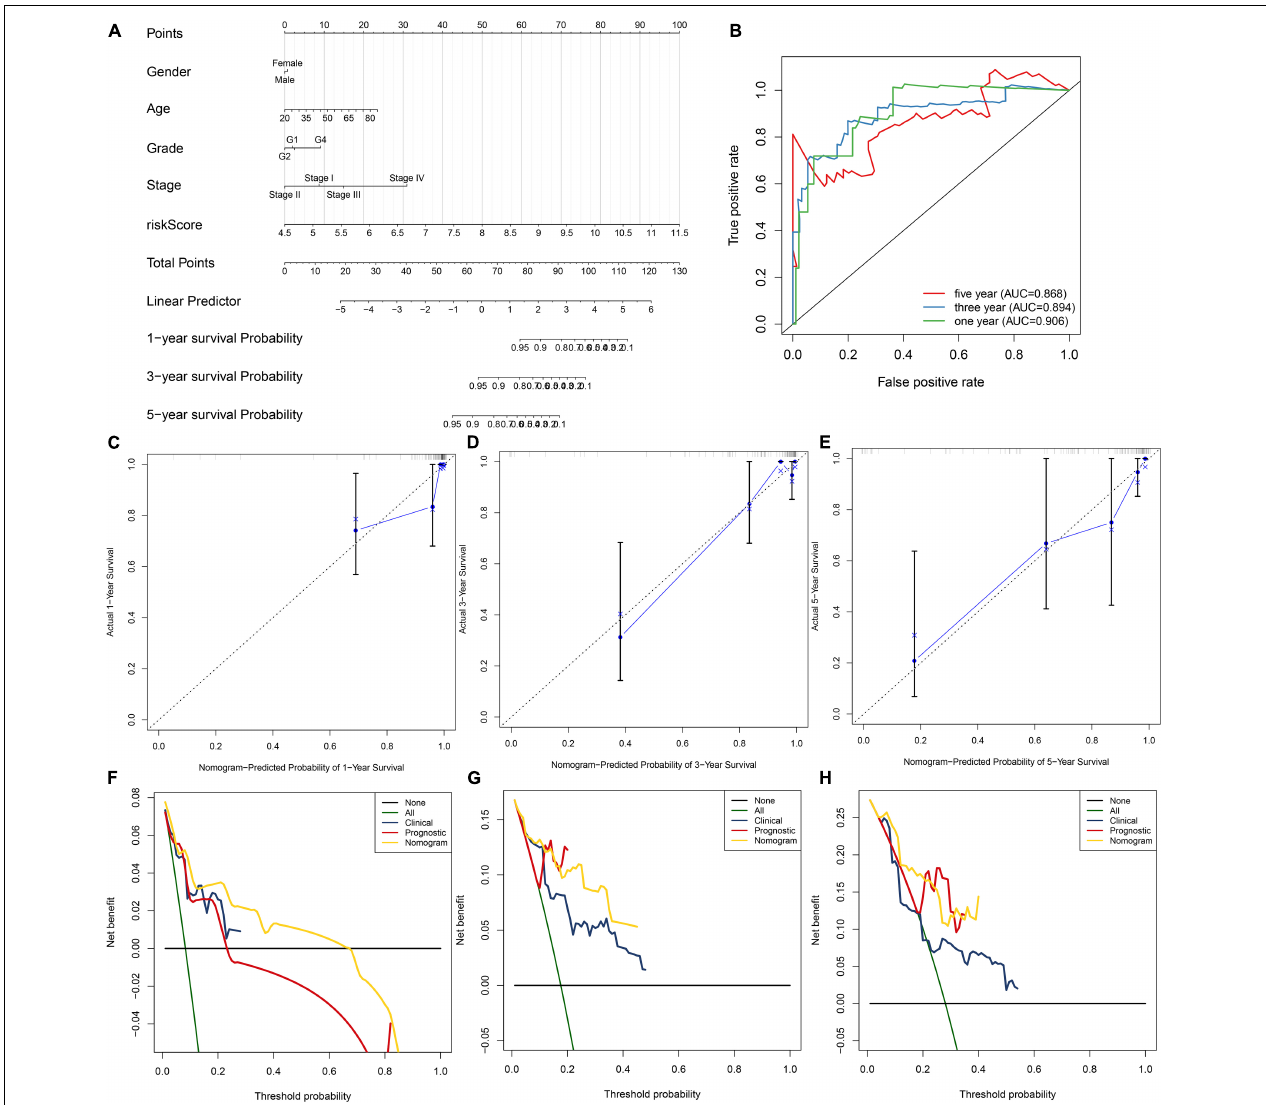
FIGURE 5 | Establishment of the nomogram for HBV-related HCC patients’ prognosis. (A) The nomogram that contained gender, age, grade, stage, and risk score for estimating one-, three- and five-year survival probabilities. (B) The ROC for evaluation of the predictive performance of this nomogram. (C–E) The calibration curves for investigating the discrepancy between nomogram-estimated and actual one-, three- and five-year survival duration. (F–H) The DCA for calculating the clinical net benefit of the nomogram, clinical factor, and prognostic factor in comparison to all or none strategies.